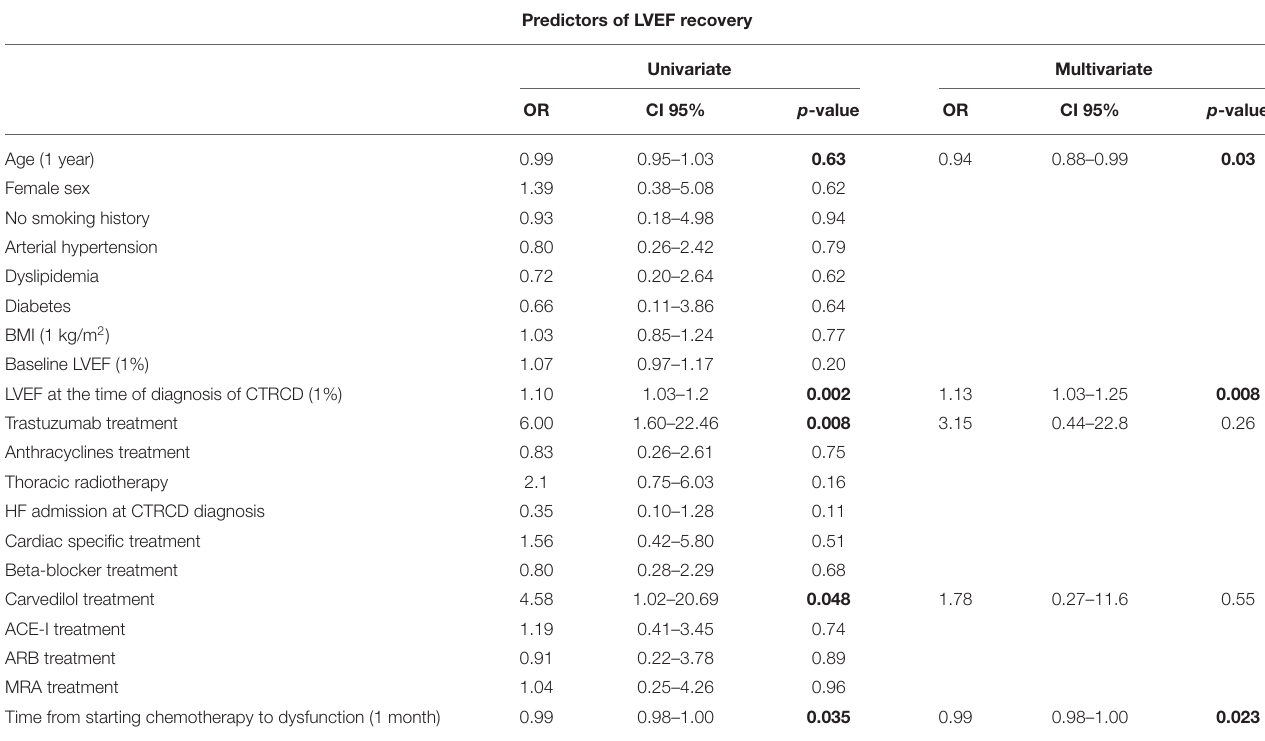
TABLE 5 | Binary logistic regression analysis to identify the predictors of LVEF recovery in the patients with cancer therapy-related